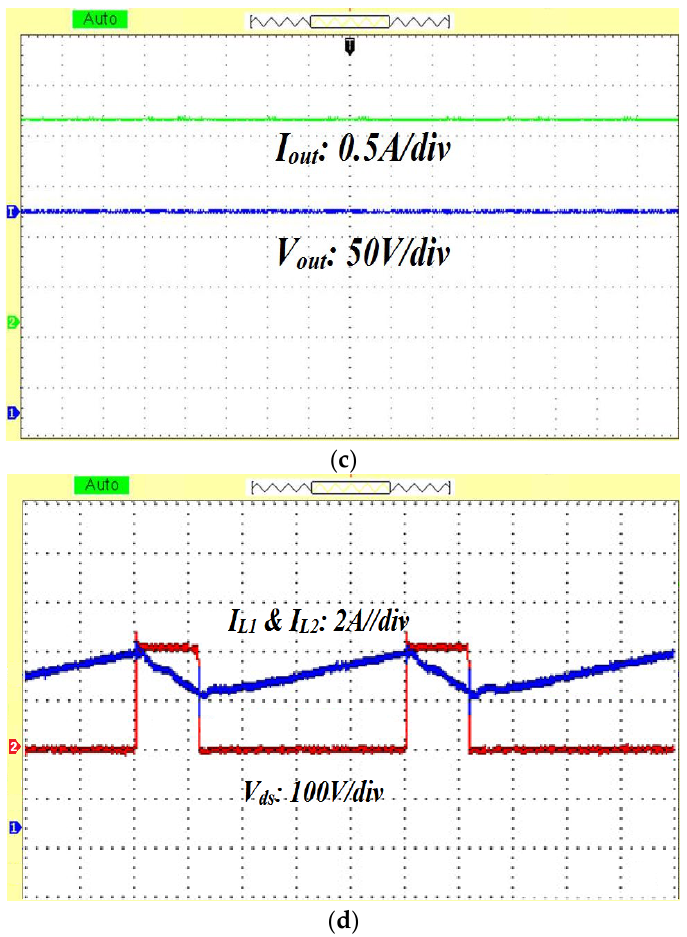
Figure 10. Experimental waveforms of the MQZS converter.